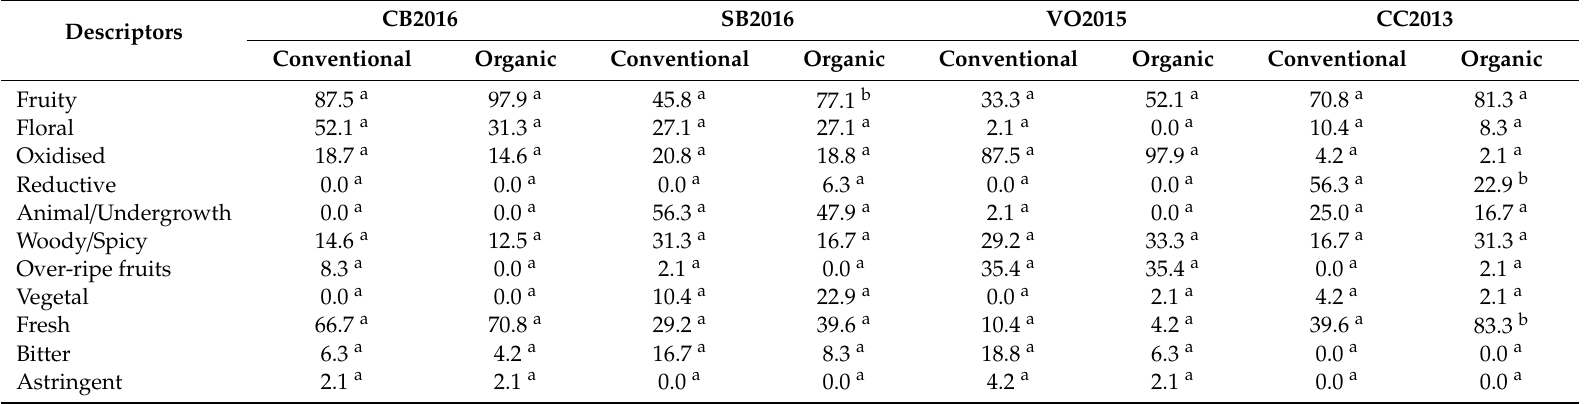
Table 7. Frequency of citation for each sensory descriptor elicited by white wines during “Conventional” and “Organic” tasting sessions *. Descriptors Conventional Organic Conventional Organic Conventional Organic Conventional Organic